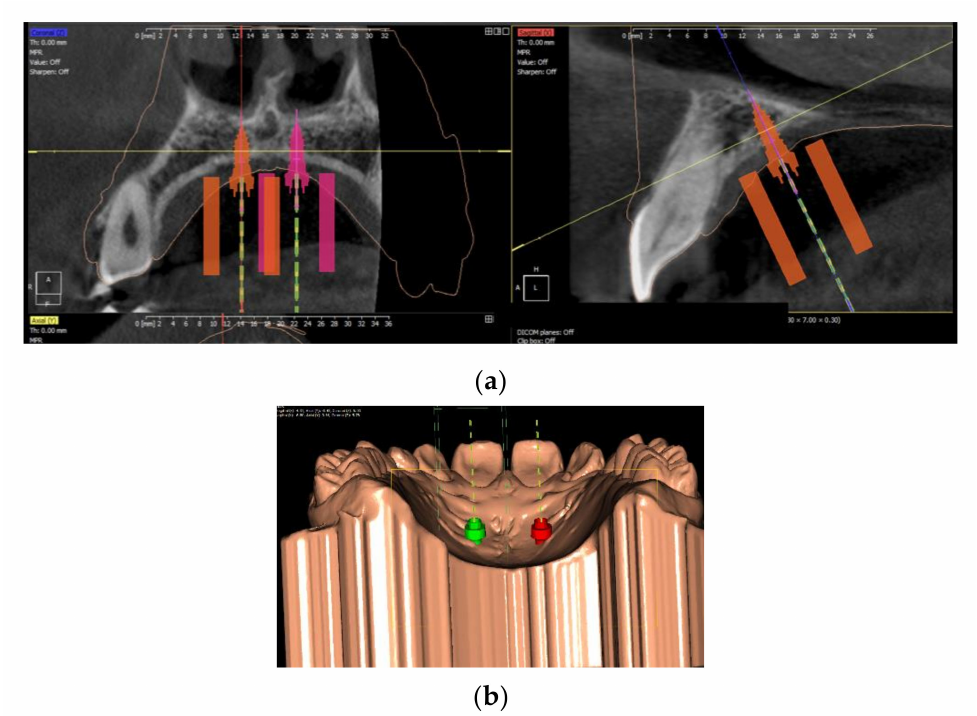
Figure 2. Digital setup determining the placement of the mini-implants and the virtual design of the surgical guides: ( a ) virtual placement of the mini-implants on the CBCT; ( b ) positioning of the mini-implants on the virtual